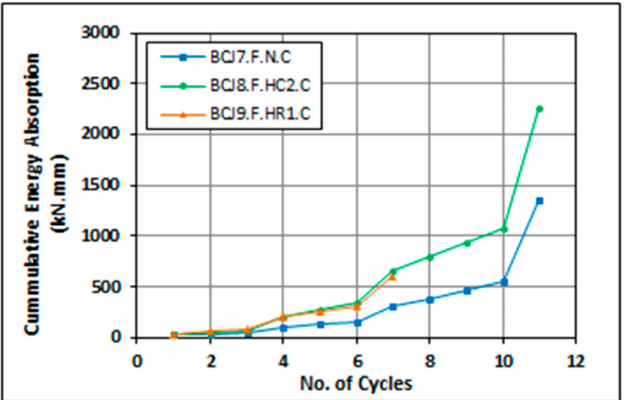
Figure 9. Variation of cumulative energy absorption for specimens subjected to cyclic